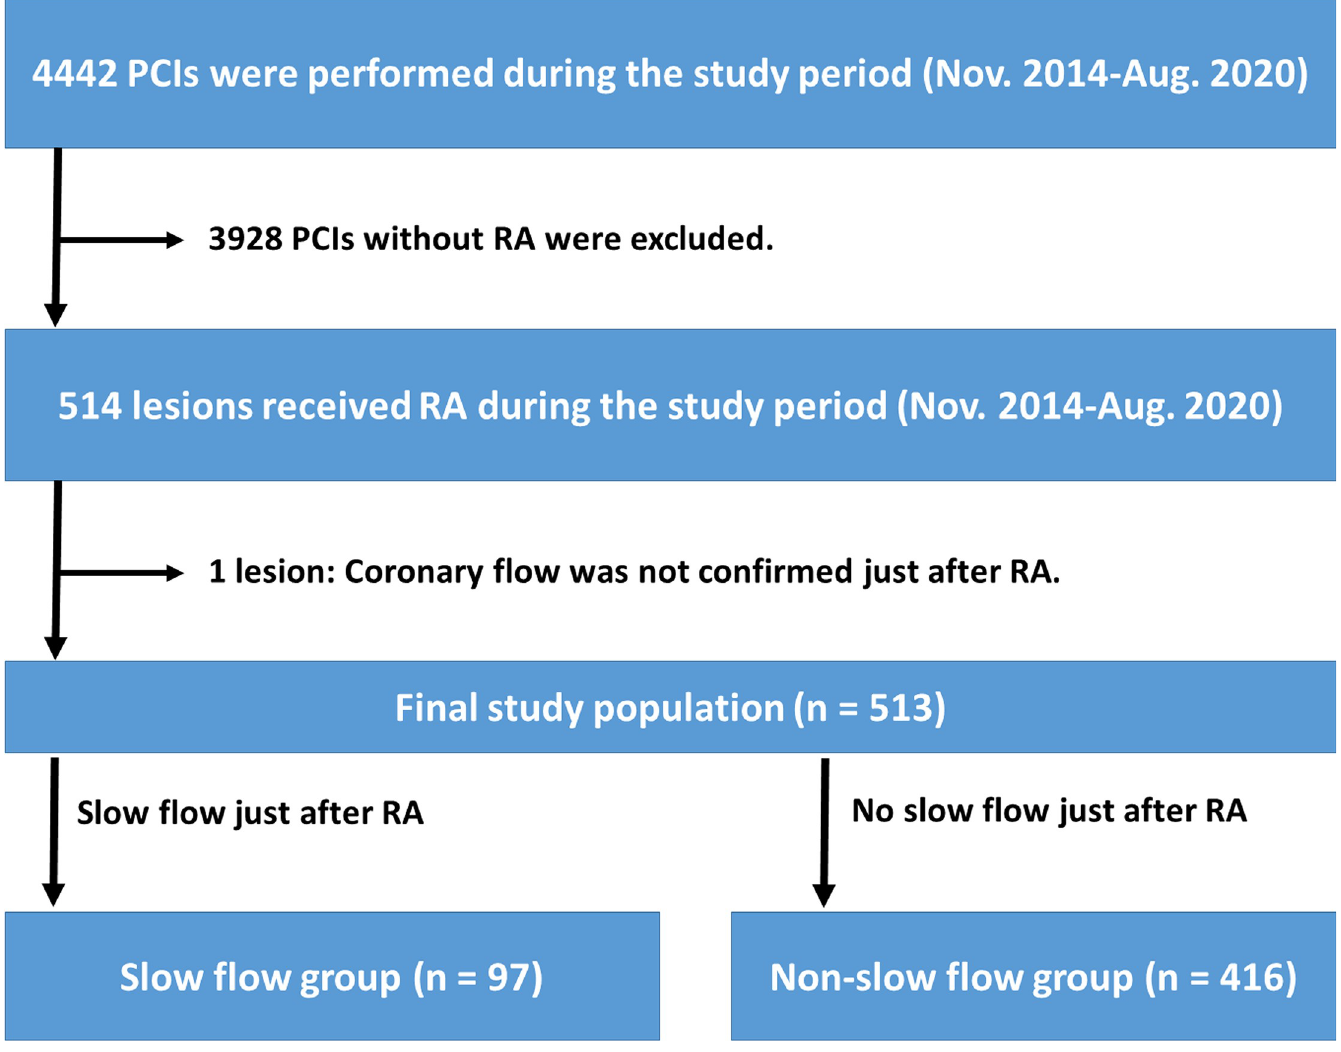
Fig 1. Study flow chart. Abbreviations: PCI = percutaneous coronary intervention, RA = rotational atherectomy. https://doi.org/10.1371/journal.pone.0250757.g001 classified into a slow flow group (n = 97) and a non-slow flow group (n = 416) according to the presence or absence of slow flow being defined as transient thrombolysis in myocardial infarc- tion (TIMI) flow grade � 2 just after RA [19]. The evaluation of TIMI flow grade just after RA was performed by an unblinded operator (K. Sakakura). The study flow chart is shown in Fig 1.